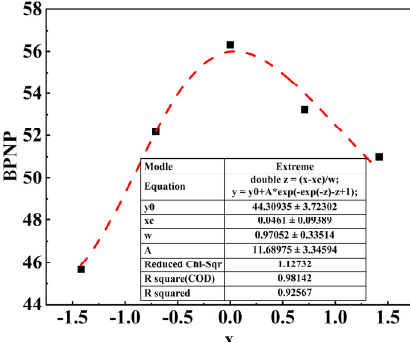
Figure 10. Exponential model fitting